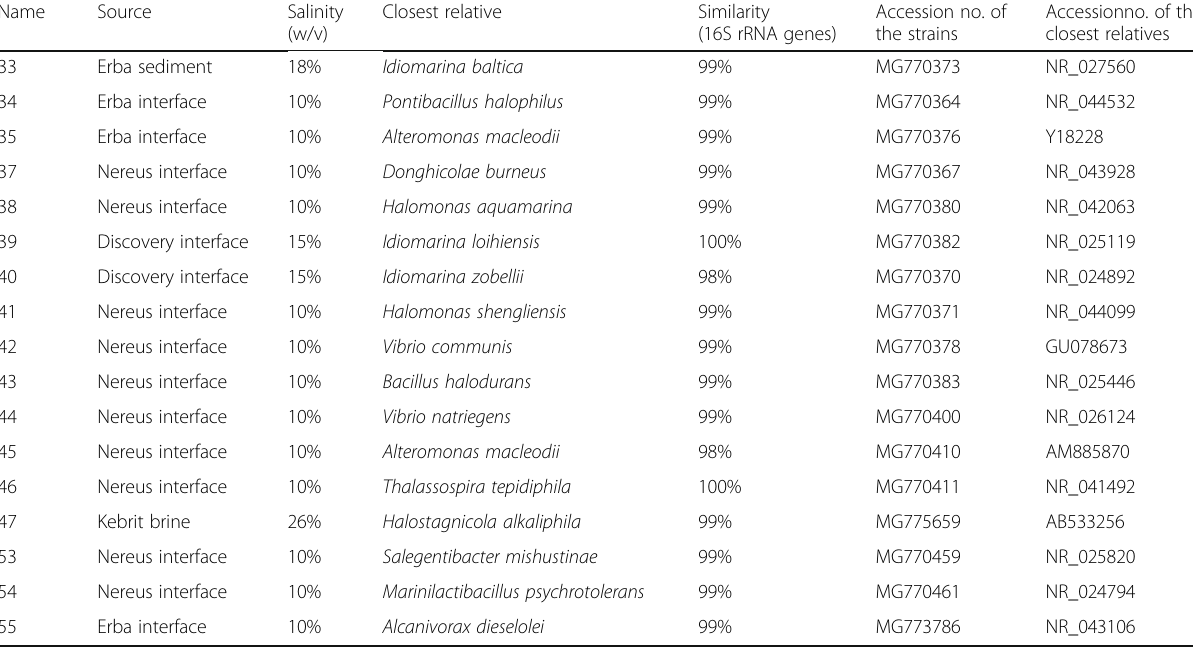
Table 1 Identification of microbial stains. Taxonomic identification based on 16S rRNA gene analysis and the source of inoculum for 60 microbial strains